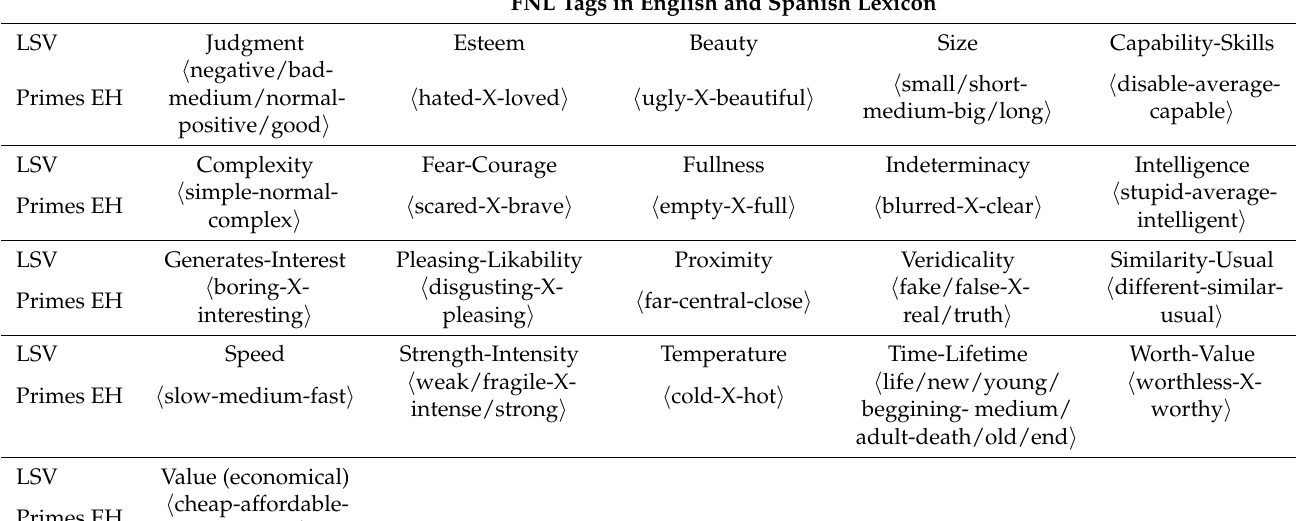
Table 2. Linguistic Semantic Variable (LSV) and Prime Evaluative Head (EH) tags in Fuzzy Natural Logic (FNL) Lexicon. FNL Tags in English and Spanish